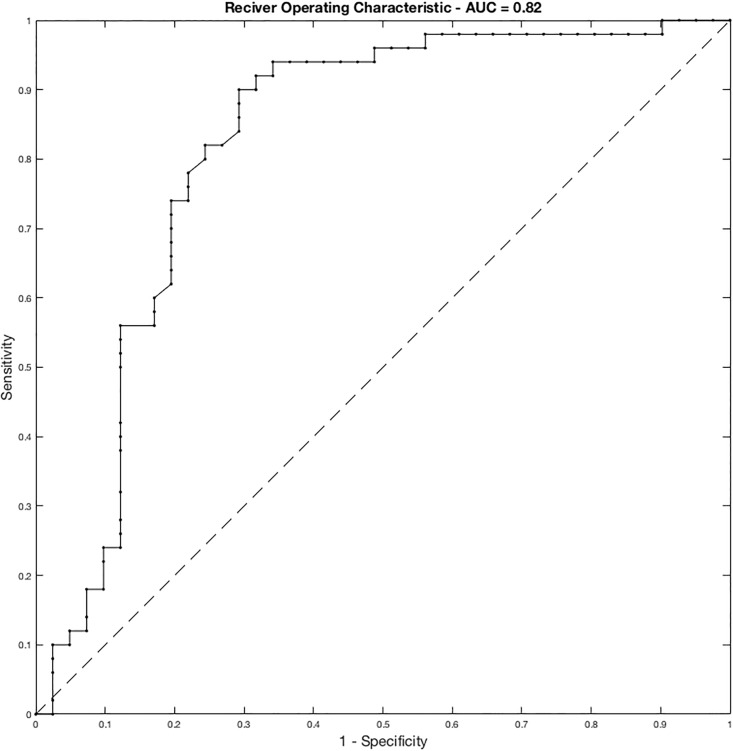
ROC curve of the proposed system.